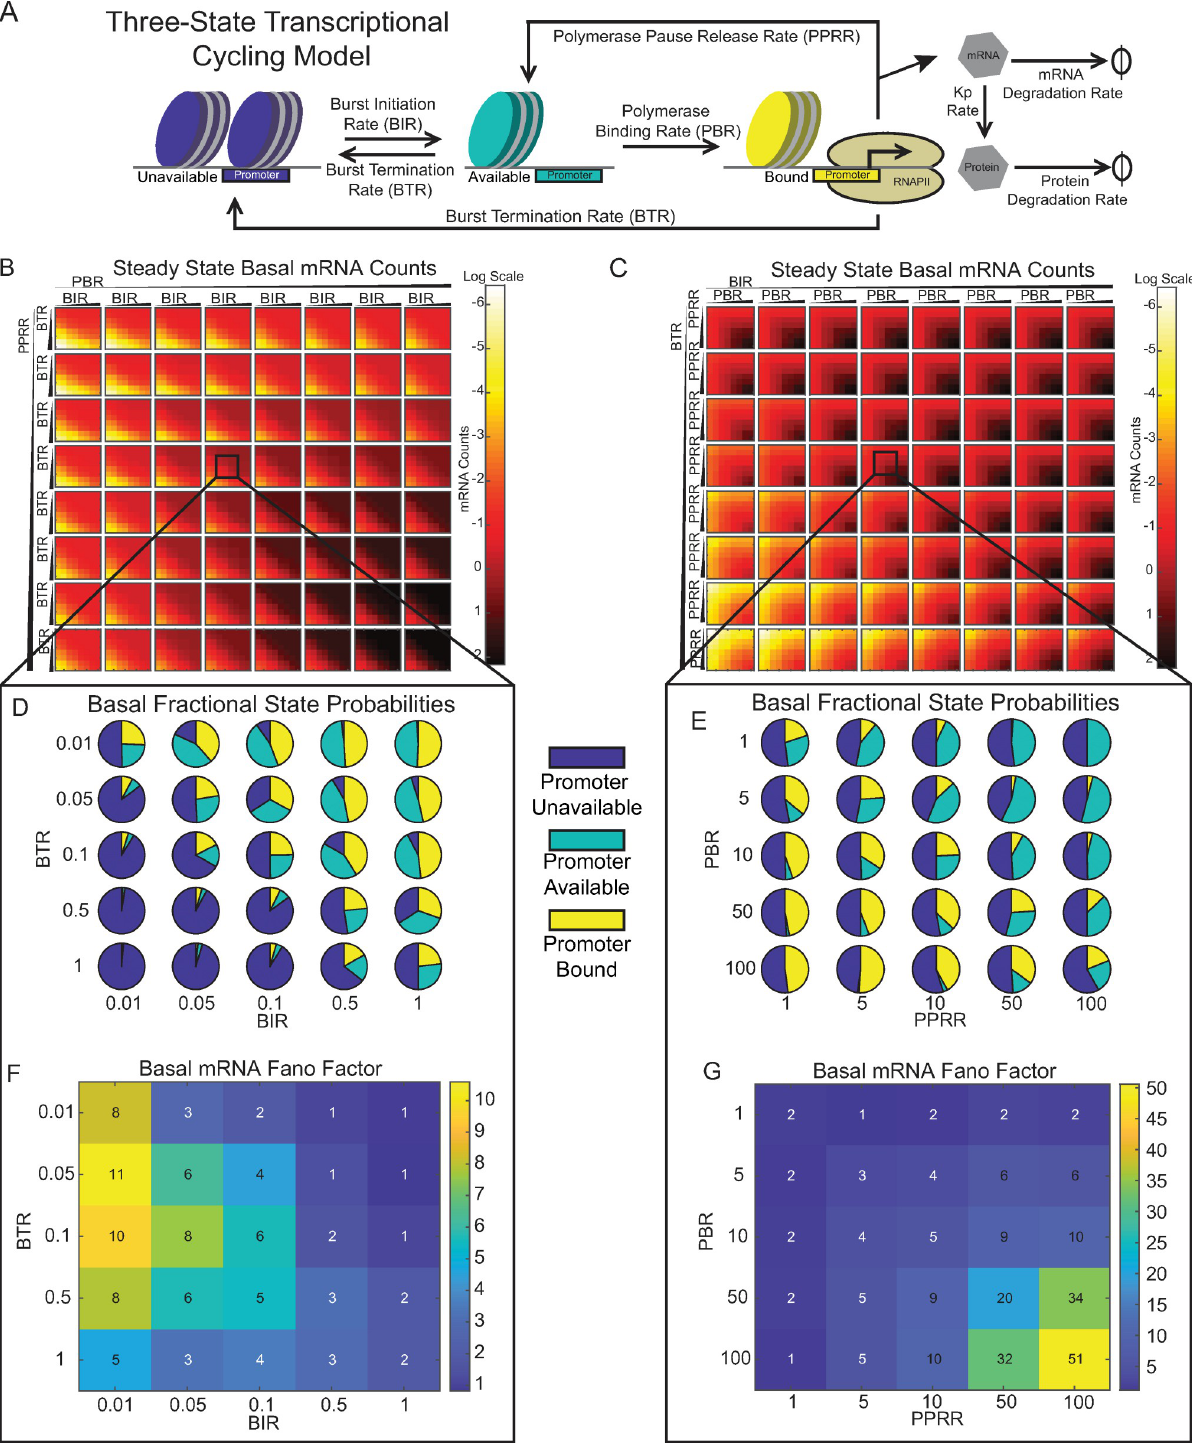
PLOS Computational Biology | https://doi.org/10.1371/journal.pcbi.1010152 September 9,